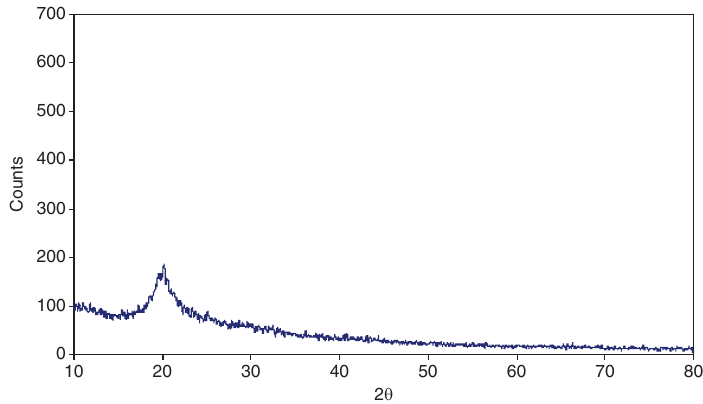
Figure 1 X-ray diffraction (XRD) of polyvinyl alcohol